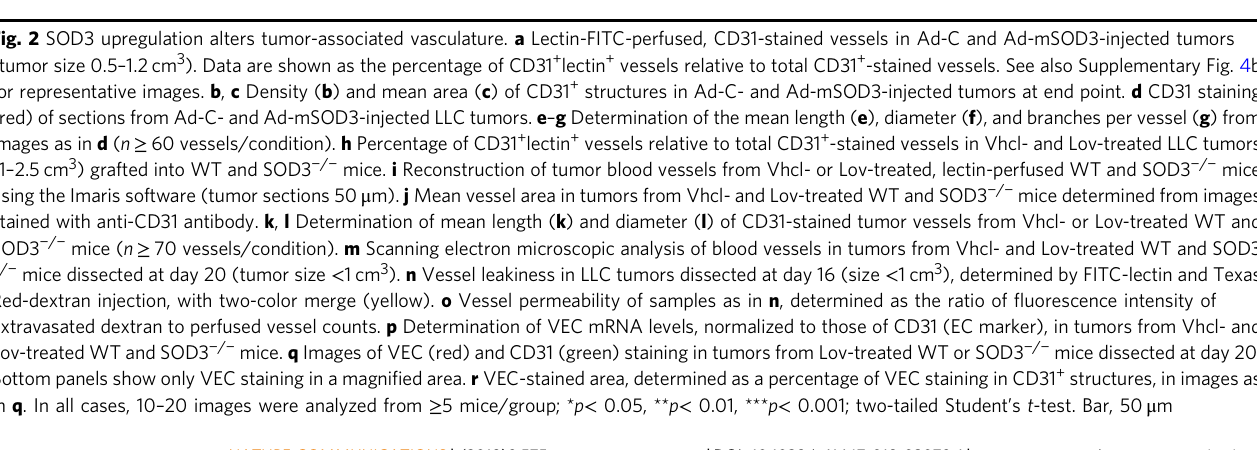
Fig. 2 SOD3 upregulation alters tumor-associated vasculature. a Lectin-FITC-perfused, CD31-stained vessels in Ad-C and Ad-mSOD3-injected tumors (tumor size 0.5 – 1.2cm 3 ). Data are shown as the percentage of CD31 + lectin + vessels relative to total CD31 + -stained vessels. See also Supplementary Fig. 4b for representative images. b , c Density ( b ) and mean area ( c ) of CD31 + structures in Ad-C- and Ad-mSOD3-injected tumors at end point. d CD31 staining (red) of sections from Ad-C- and Ad-mSOD3-injected LLC tumors. e – g Determination of the mean length ( e ), diameter ( f ), and branches per vessel ( g ) from images as in d ( n ≥ 60 vessels/condition). h Percentage of CD31 + lectin + vessels relative to total CD31 + -stained vessels in Vhcl- and Lov-treated LLC tumors (1 – 2.5 cm 3 ) grafted into WT and SOD3 − / − mice. i Reconstruction of tumor blood vessels from Vhcl- or Lov-treated, lectin-perfused WT and SOD3 − / − mice using the Imaris software (tumor sections 50 μ m). j Mean vessel area in tumors from Vhcl- and Lov-treated WT and SOD3 − / − mice determined from images stained with anti-CD31 antibody. k , l Determination of mean length ( k ) and diameter ( l ) of CD31-stained tumor vessels from Vhcl- or Lov-treated WT and SOD3 − / − mice ( n ≥ 70 vessels/condition). m Scanning electron microscopic analysis of blood vessels in tumors from Vhcl- and Lov-treated WT and SOD3 − / − mice dissected at day 20 (tumor size < 1cm 3 ). n Vessel leakiness in LLC tumors dissected at day 16 (size < 1 cm 3 ), determined by FITC-lectin and Texas Red-dextran injection, with two-color merge (yellow). o Vessel permeability of samples as in n , determined as the ratio of fl uorescence intensity of extravasated dextran to perfused vessel counts. p Determination of VEC mRNA levels, normalized to those of CD31 (EC marker), in tumors from Vhcl- and Lov-treated WT and SOD3 − / − mice. q Images of VEC (red) and CD31 (green) staining in tumors from Lov-treated WT or SOD3 − / − mice dissected at day